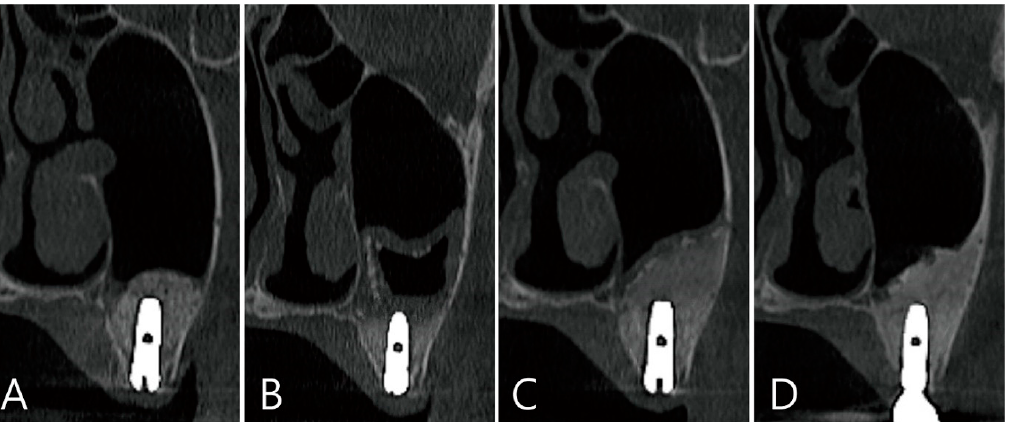
Figure 13. The coronal image of the CBCT scanned at the #27 implant site was examined: ( A ) in the image taken immediately after surgery, there was no leakage of bone graft particles; ( B ) however, a very large grafting void appeared in the image taken one week after surgery; ( C ) this grafting void showed a cystic appearance in the implant apex, although its size was reduced on CBCT taken after 6 months; ( D ) in CBCT taken 2 years after the grafting void was removed, the grafting void was replaced with new bone.